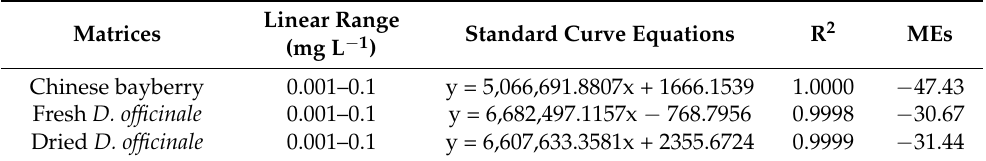
Table 1. Standard curve equations and matrix effects (MEs) of metalaxyl in Chinese bayberry and D. officinale